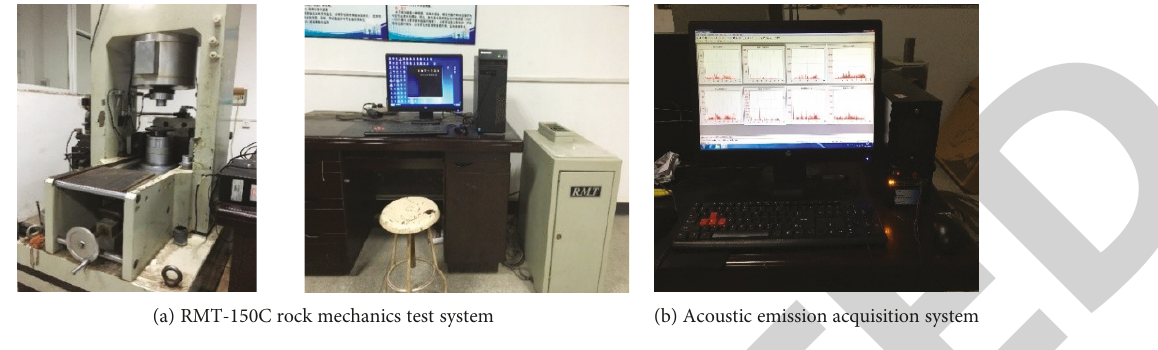
Figure 8: Test instrument. Table 2: Acoustic emission acquisition parameter setting.